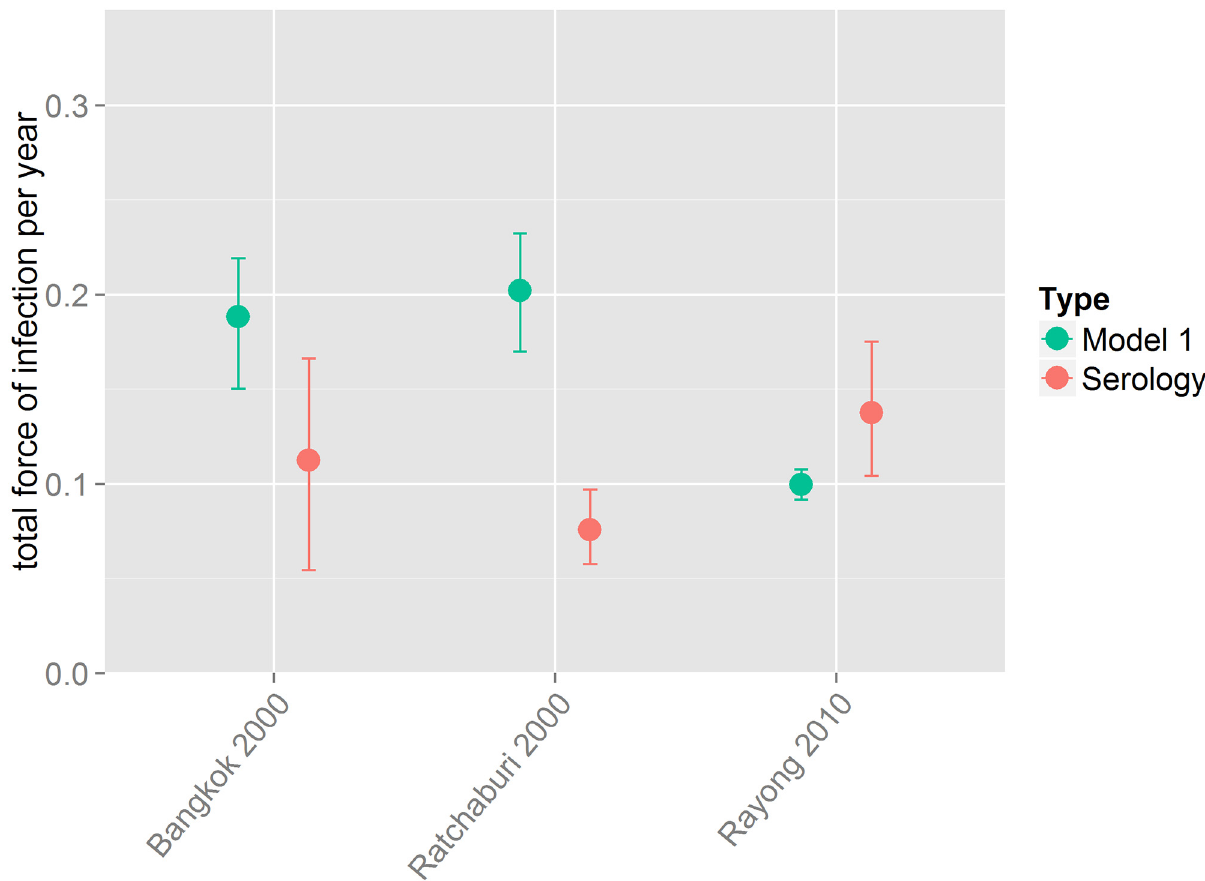
Fig 5. Posterior median estimates of the total force of infection from the model fitted to incidence data (model 1) and model A (as described in [13]) to age-stratified seroprevalence data (serology) from Thailand where incidence and serology data were available from the same year and